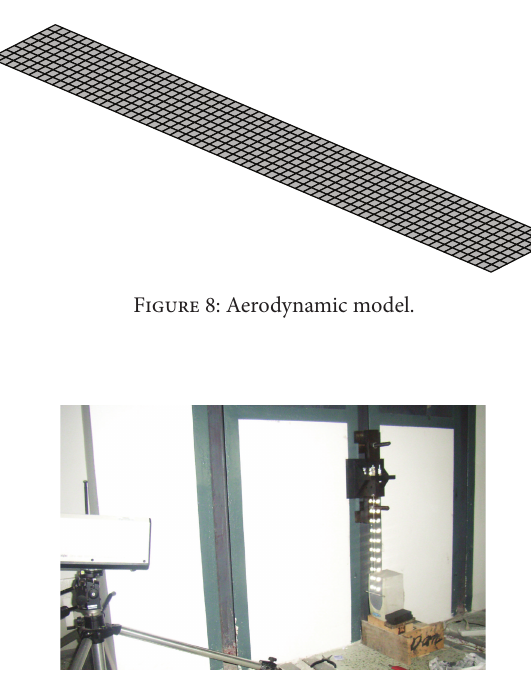
Figure 9: Ground vibration test (wing was fixed vertically).